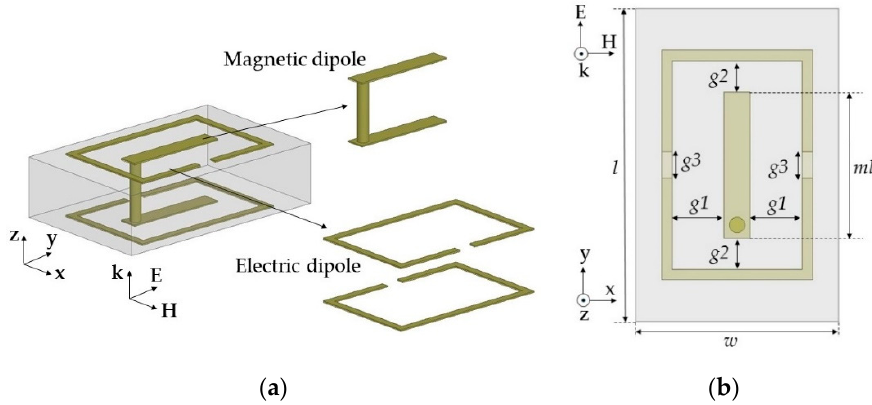
Figure 8. Electric and magnetic dipoles in the topology 3 structure from the ( a ) side–side view and ( b ) top view.